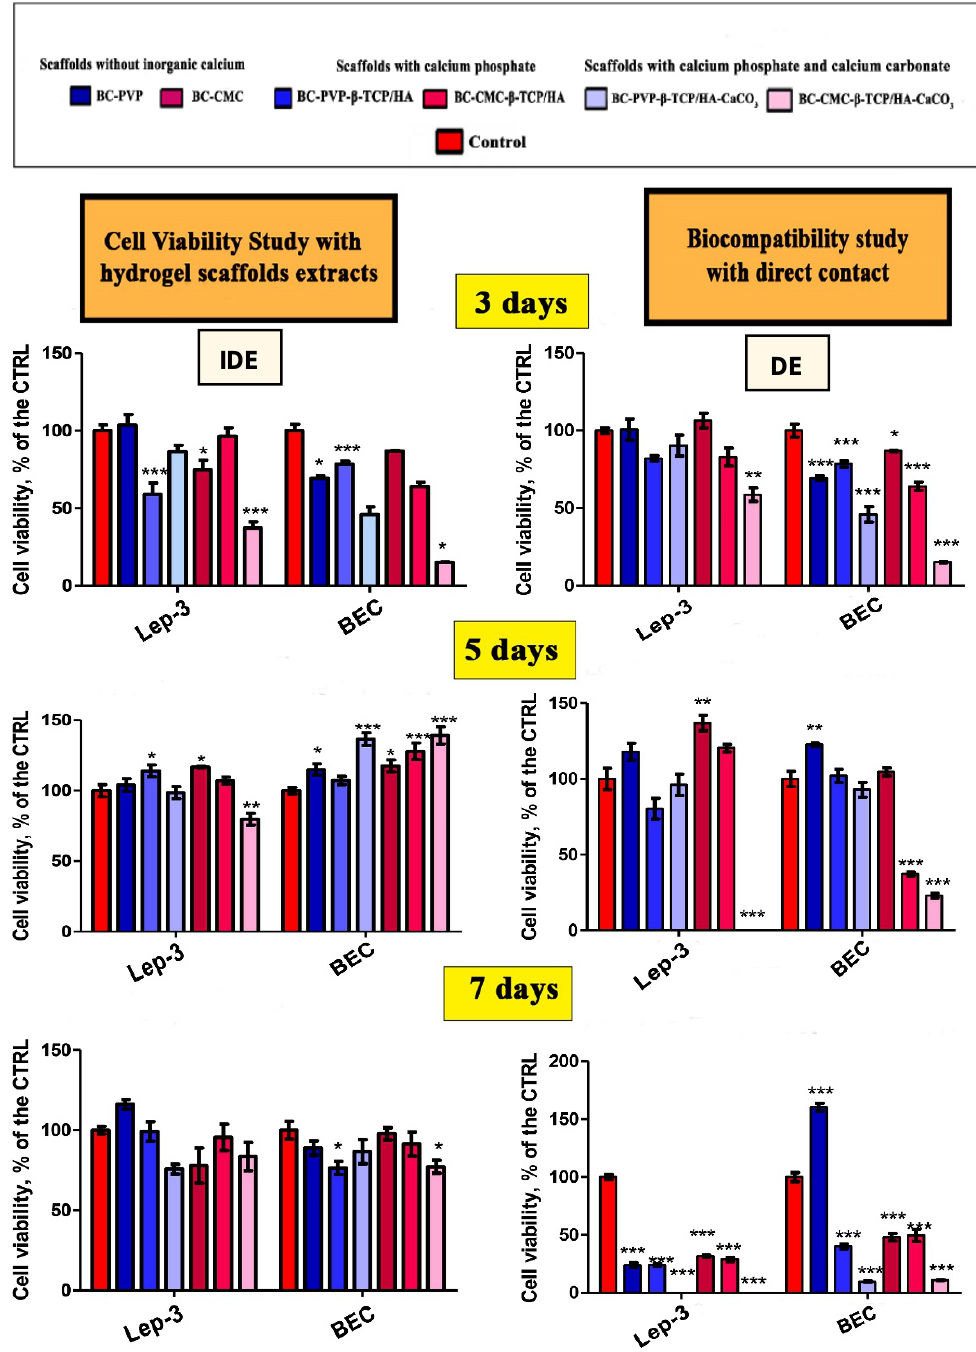
Figure 1. Human fibroblast,Lep-3 and mouse bone explant cells (BEC) cellular viability (proliferation profiles) after incubation with six different BC based hydrogel scaffolds (scaffolds without inorganic calcium, scaffolds with calcium phosphate, scaffolds with calcium phosphate and CaCO 3 ); established by indirect (IDE) and direct experiments (DE). * p < 0.05; ** p < 0.005; *** p < 0.0001 as compared to the control.